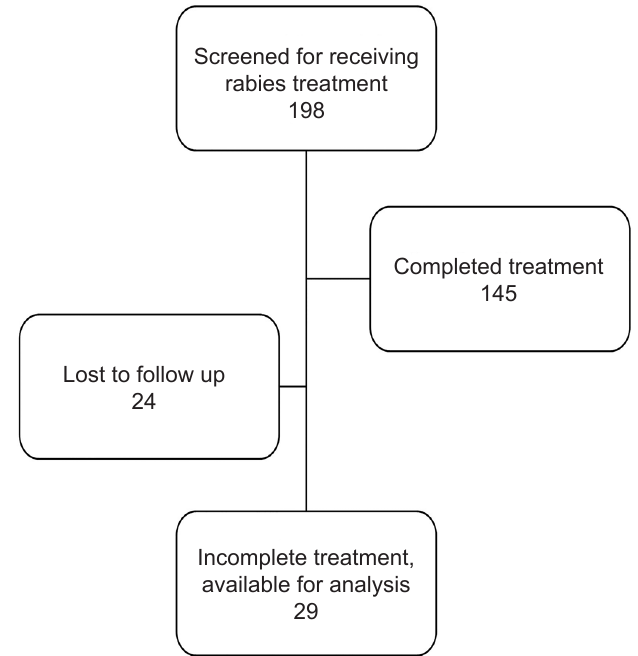
Figure. Treatment outcome grouping of patients who did or did not complete rabies vaccination